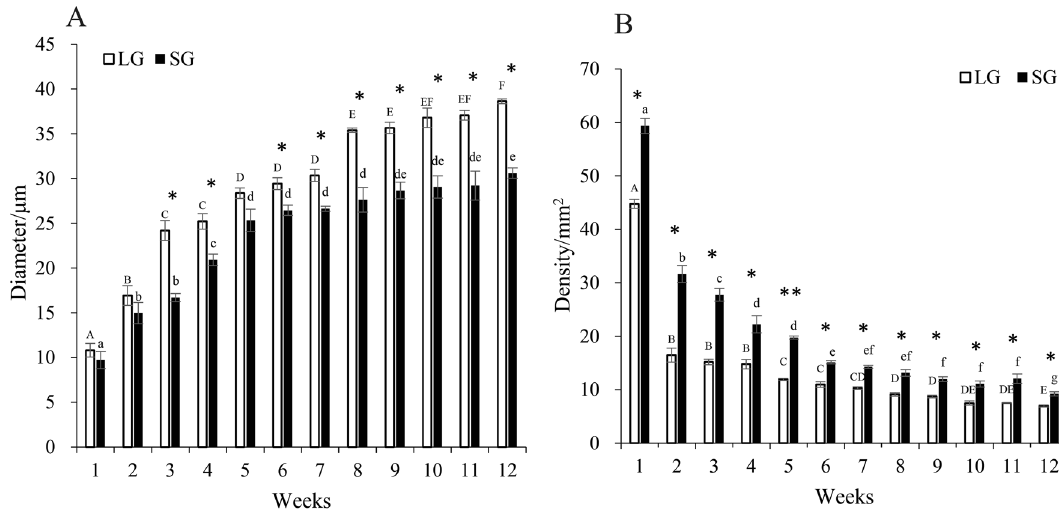
Figure 3. The weekly comparison of muscle fiber diameter ( A ) and density ( B ) between LG and SG loach. Note The different lowercase letters above the bar represent the comparison within the SG loach and the different uppercase letters represent the comparison within the LG loach. Vertical bars represent mean ± SD ( n = 6 fish individuals); * show the significant difference in total length between LG and SG; * p < 0.05, ** p <